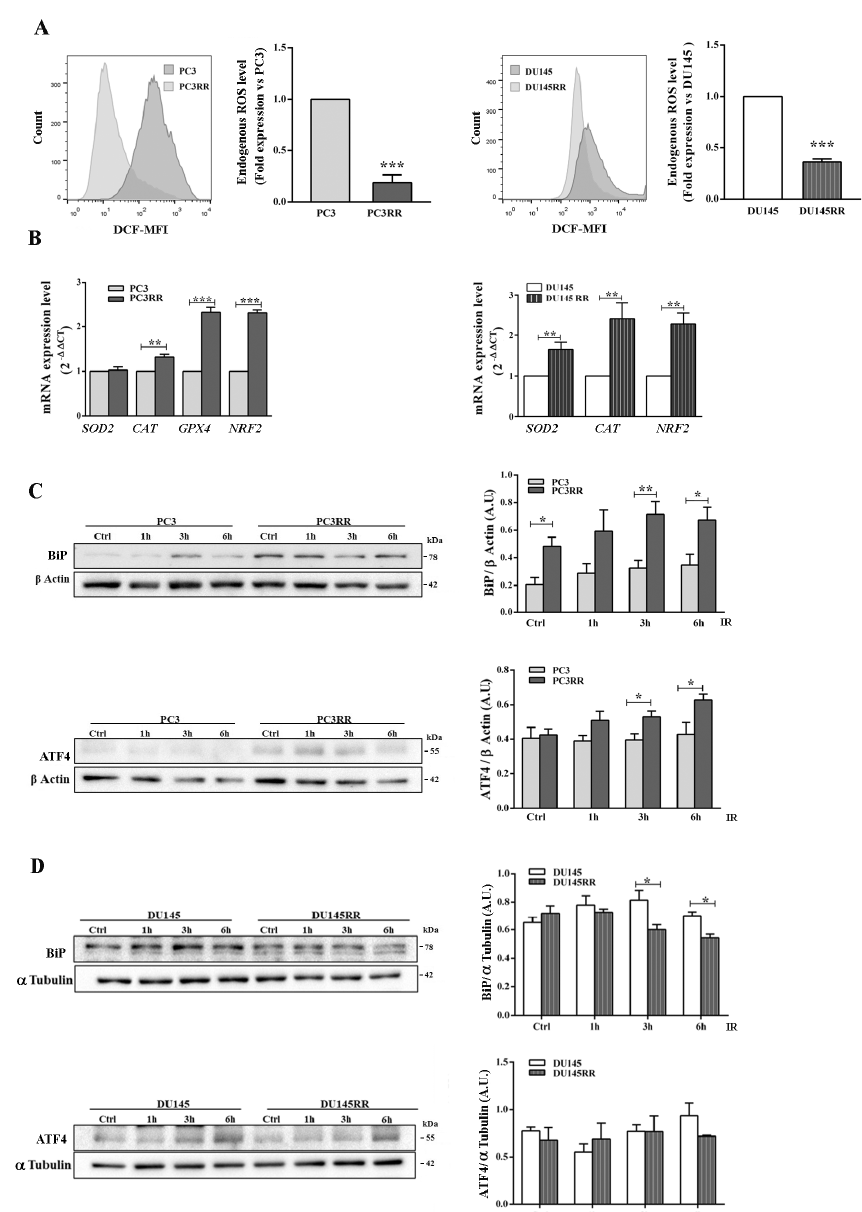
Figure 9. Antioxidant response and UPR activation induced by IR in PC3RR and DU-145RR cells. ( A ) Endogenous ROS levels in parental PCa and PCaRR were measured with flow cytometry using DCFDA dye fluorescence. The graphs represent the fold expression of ROS levels, in which the median of fluorescence of parental PC3 or DU-145 cells is set as one. The values are from three independent experiments. Representative flow cytometry histograms are shown. ( B ) The mRNA levels of the indicated genes were quantified by qRT-PCR, and β -Actin was used as an internal control. To evaluate UPR pathway, Western blot analysis was performed on cell lysates from unirradiated cells (Ctrl) or cells irradiated with 4 Gy and collected 1, 3 and 6 h after IR in PC3/PC3RR ( C ) DU- 145/DU-145RR ( D ). β -Actin or α -Tubulin were used as internal controls. Each blot is representative of three experiments. The histograms represent the densitometric analysis of three separate Western blots evaluated as arbitrary units (A.U.). Data represent the mean ± S.E.M. derived from at least three independent experiments. PC3RR vs. PC3 and DU-145RR vs. DU-145; * p < 0.05, ** p < 0.01, *** p < 0.001, Student’s unpaired t